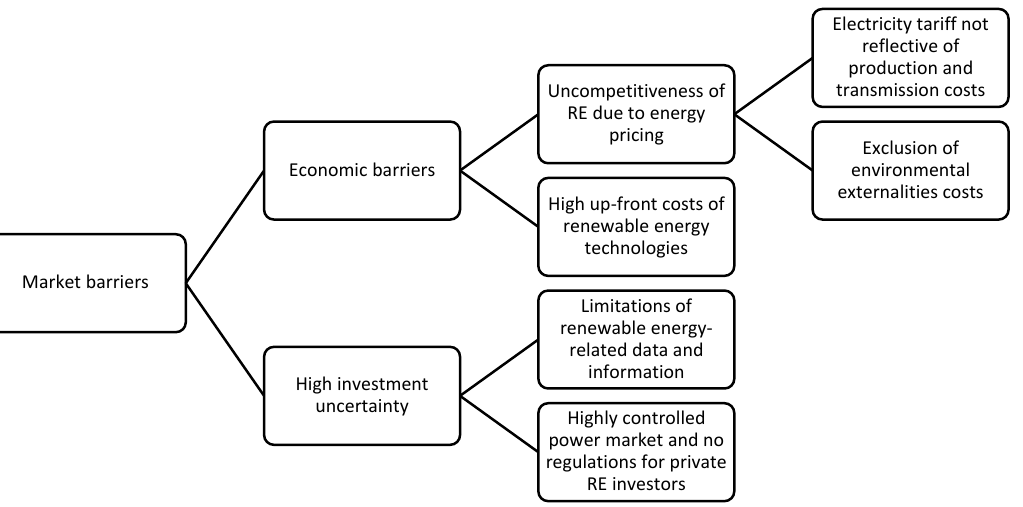
Figure 3. Market barriers for renewable energy adoption in the GCC. Adapted from [48].